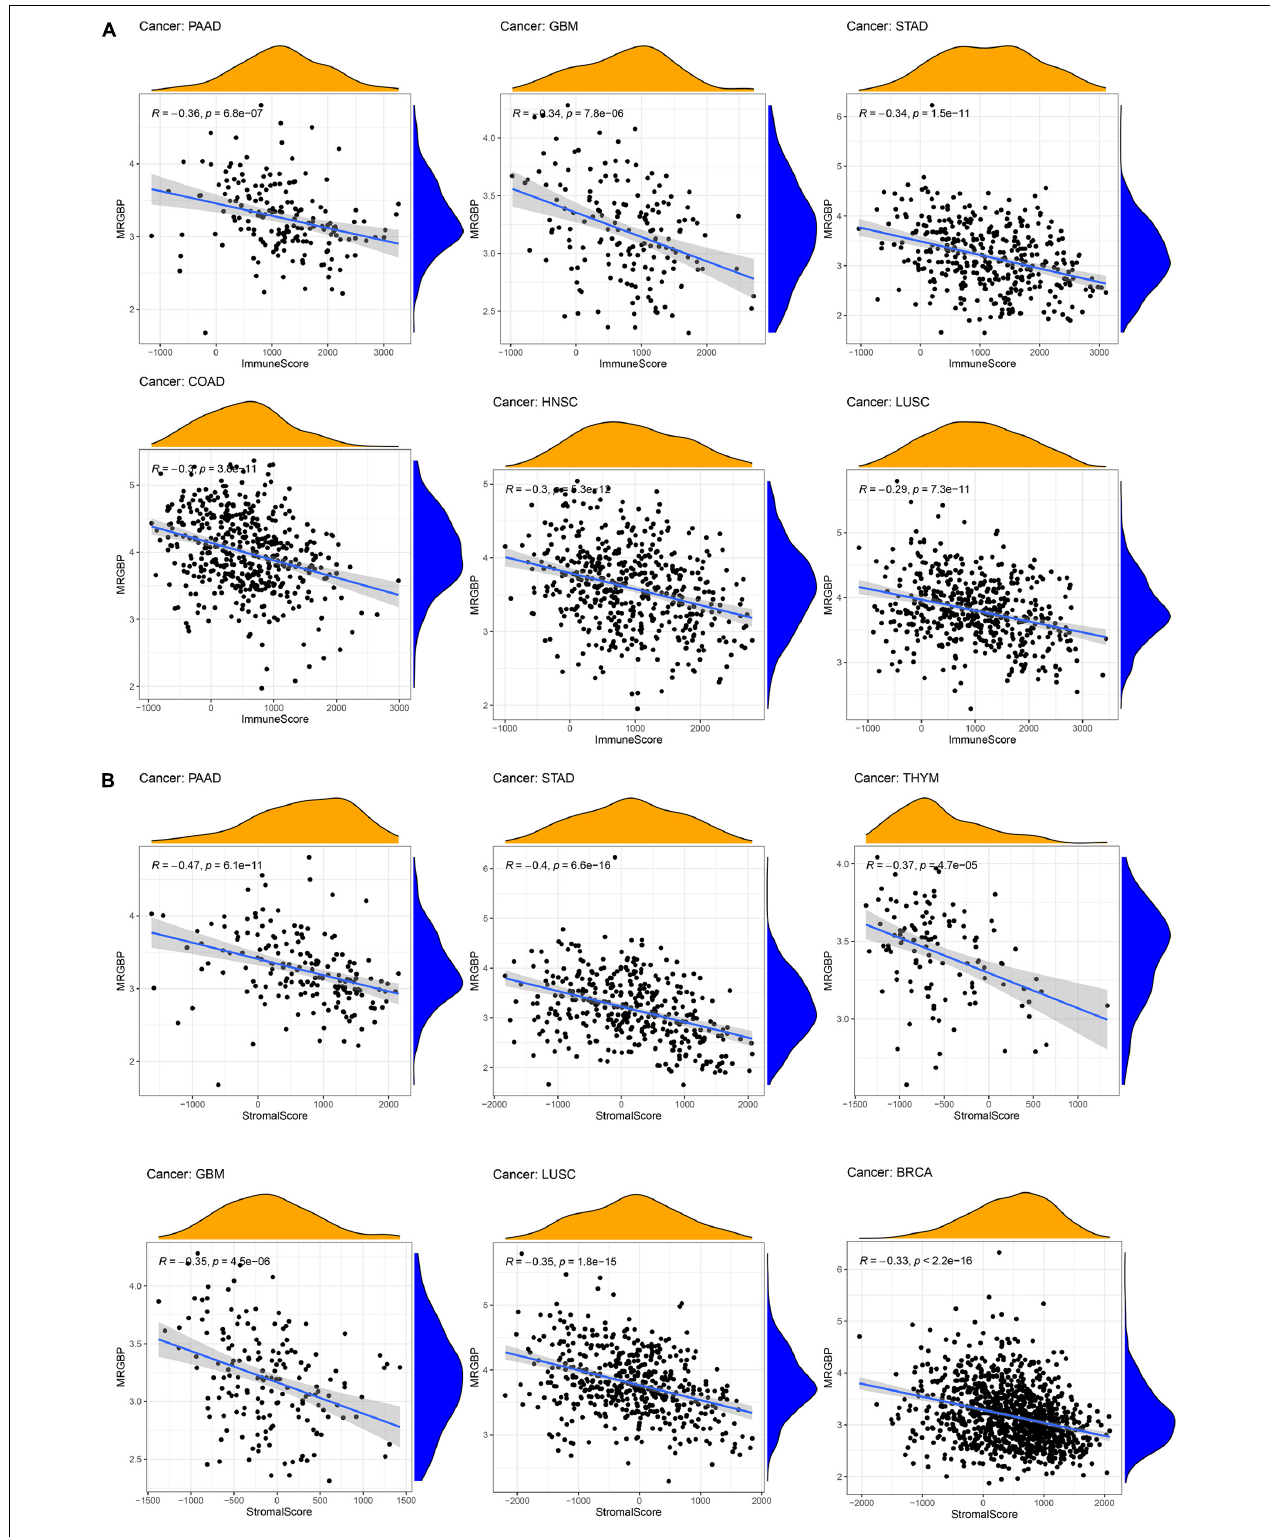
FIGURE 8 | Association between MRGBP expression and immune scores (A) in PAAD, GBM, STAD, COAD, HNSC, and LUSC and stromal scores (B) in PAAD, STAD, THYM, GBM, LUSC, and BRCA.